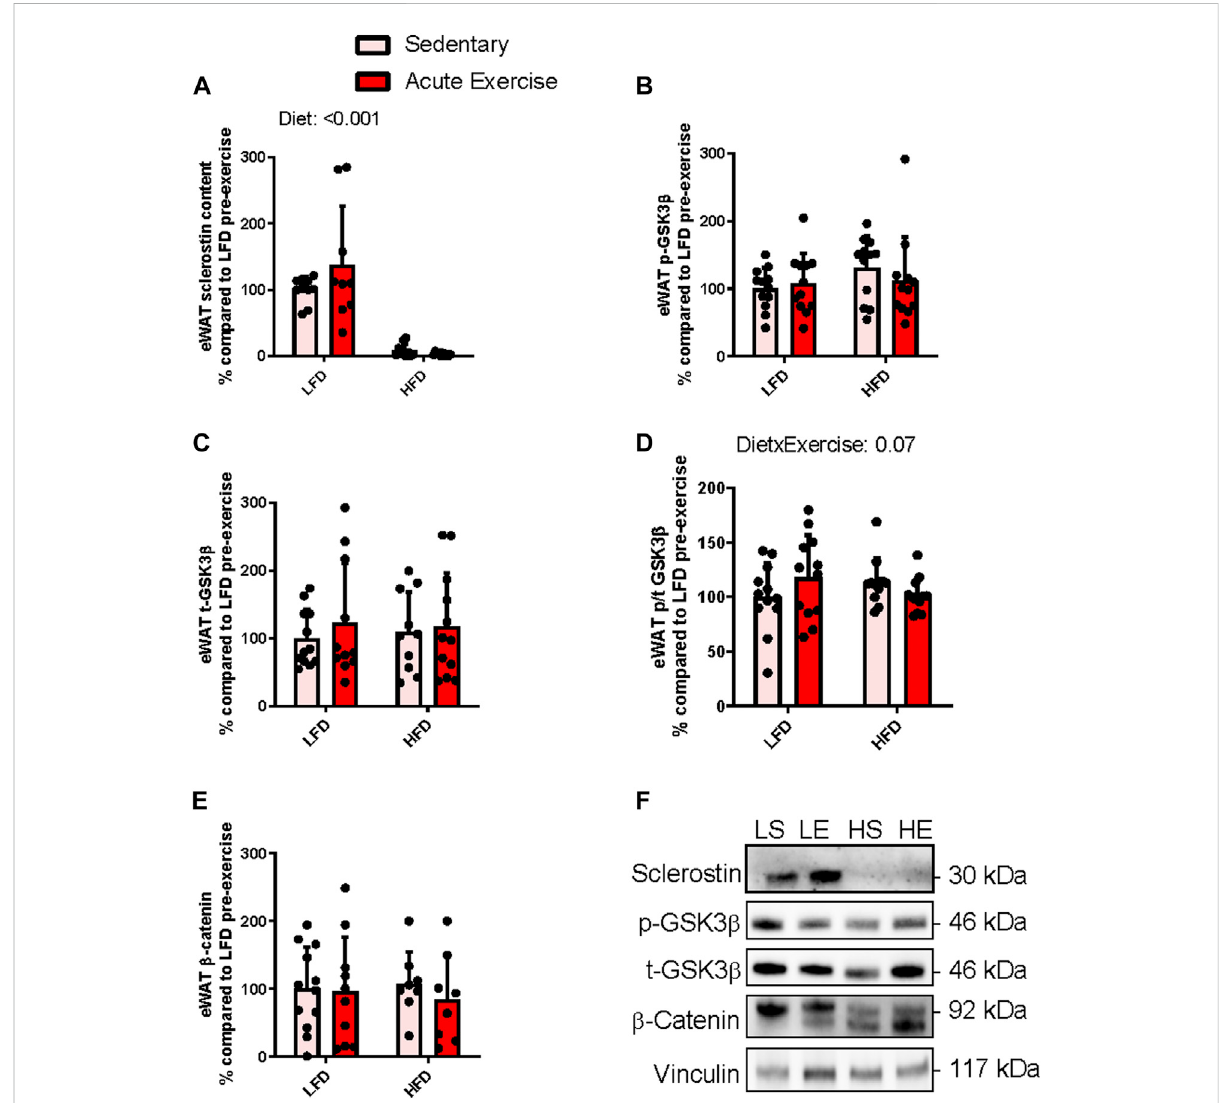
FIGURE 3 Response of eWAT sclerostin content (A) , serine9 phosphorylation status (B,D) both total GSK3b content (C) , and total b-catenin content (E) to HFD and acute exercise, as well as representative immunoblots (F) . Light grey bars represent sedentary mice and dark grey bars represent mice sampled 2 hfollowing 2 h of acute enduranceexercise and are grouped by diet; LFD = low fat diet; HFD = high fat diet. Proteins are corrected for by thehousekeeping protein vinculinand are all relative to LFD sedentary mice, data are presented as means ± SD and main effects are presented ongraphsonlyiftheyareeither closetooraresigni fi cant.A two-wayfactorialANOVA wasused toexaminemaineffectsfordietandexerciseas well their interaction. Tukey correction was used for multiple pairwise